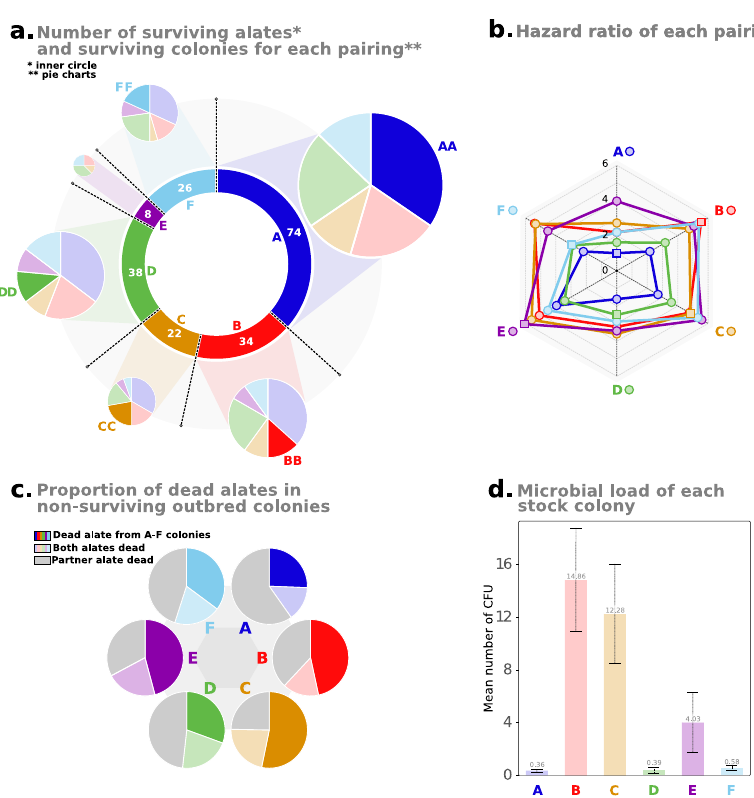
Fig. 2 Survival and microbial load of alates according to their colony of origin. a Colony of origin of the 202 surviving alates 14 days after colony establishment (inner circle). For each colony of origin, pie charts represent the distribution of surviving inbred and outbred pairings; outbred pairings are divided and light-colored according to the colony of origin of the partner, inbred pairings are represented by bright colors. b Radar plot represents the hazard ratio of each inbred and outbred pairings in the fi rst 14 days after colony establishment. Parings with low hazard ratios (i.e., close to the center) are characterized by low mortality. Parings with at least one of the partners originating from stock colony A are colored in blue (B in red; C in orange; D in green; E in purple and F in light blue). Outbred pairings are marked with a circle, while outbred pairings are represented with a square. c Pie charts represent the proportion of dead alates in non-surviving outbred colonies for each stock colony. d Levels of microbial load of each stock colony, bars represent standard